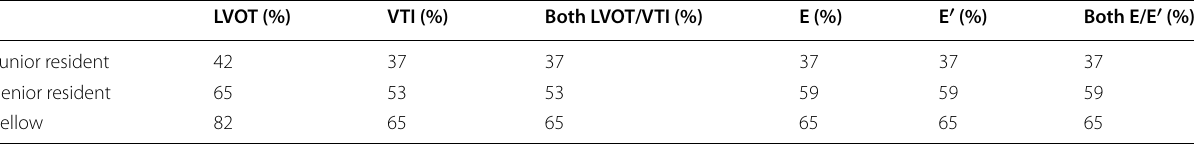
Table 4 Advanced cardiac measurements obtained by level of training LVOT (%) VTI (%) Both LVOT/VTI